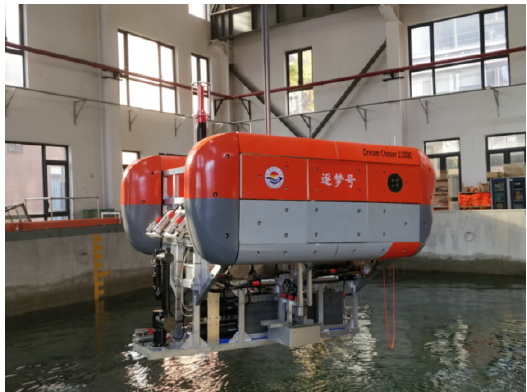
Figure 18. The underwater equilibrium and functional tests in the water